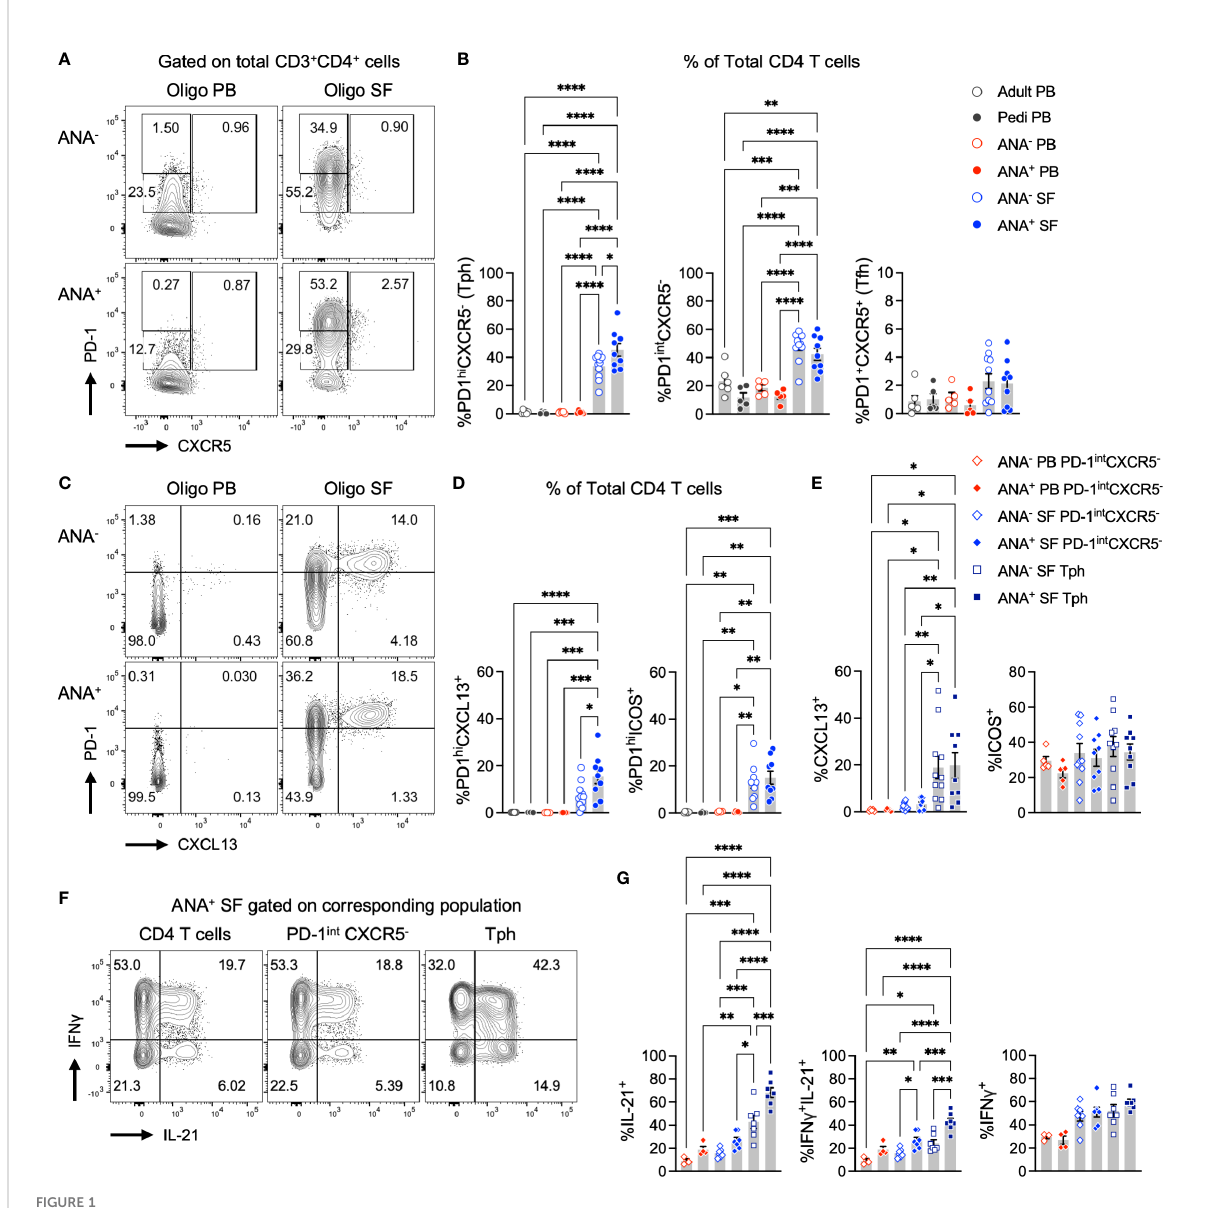
FIGURE 1 T peripheral helper cells expressing B cell help factors are enriched in the synovial fl uid of autoantibody-positive oligo JIA patients. (A) Representative fl ow staining of B cell-helper CD4 + T cell populations in oligo JIA PB and SF, gated on total CD3 + CD4 + T cells. In each experiment, the PD-1 hi gate was set by evaluating untstimulated PB samples from oligo JIA patients (often paired PB and SF sample from the same patient were used) and controls. This PD-1 hi gate was then applied to SF samples from oligo JIA patients evaluated during the same experiment. (B) Percent of Tph (PD-1 hi CXCR5 - ), PD-1 int CXCR5 + , and Tfh (PD-1 + CXCR5 + ) cells among CD4 + T cells in the SF of oligo JIA patients (ANA - : n=11, ANA + : n=9, blue circles), and in the PB of oligo JIA patients (ANA - : n=5, ANA + : n=5, red circles) and controls (pediatric: n=5, adult: n=6, black circles). (C) Representative fl ow staining of PD-1 hi CXCL13 + T cells in oligo JIA PB and SF, gated on total CD3 + CD4 + T cells. (D) Percent of PD-1 hi CXCL13 + and PD-1 hi ICOS + cells among CD4 + T cells in the SF of oligo JIA patients (ANA - : n=10-11, ANA + : n=9), and in the PB of oligo JIA patients (ANA - : n=5, ANA + : n=5) and controls (pediatric: n=4-5, adult: n=6). (E) Percent of CXCL13 + and ICOS + cells among CD4 + PD-1 int CXCR5 - and Tph subsets in the SF (ANA - : n=10-11, ANA + : n=9) and in the PB (ANA - : n=5, ANA + : n=5) of oligo JIA patients. (F) Representative fl ow staining of cytokine production in oligo JIA PB and SF, gated on CD4 + T cells and subpopulations. (G) Percent of IL-21 + , IFN g + and dual IFN g + IL-21 + cells among CD4 + PD-1 int CXCR5 - and Tph subsets in the SF (ANA - : n=7, ANA + : n=7) and in the PB (ANA - : n=3, ANA + : n=5) of oligo JIA patients. Oligo JIA, oligoarticular juvenile idiopathic arthritis; PB, peripheral blood; SF, synovial fl uid; pedi, pediatric; ANA, antinuclear antibody; Tph, T peripheral helper cell; Tfh, T follicular helper cell. Summary data on bar graphs are mean ± standard error. P-value <0.05 (*); <0.01 (**), <0.001 (***), <0.0001 (****). Statistical testing: one-way ANOVA followed by multiple t-tests with Turkey